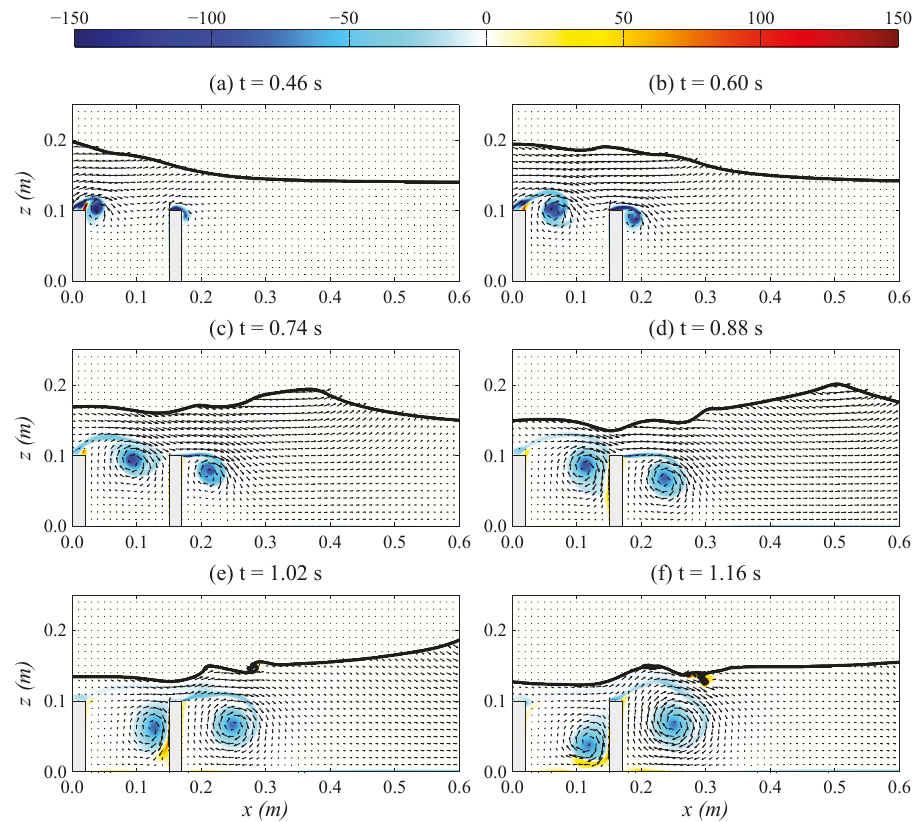
Figure 6. Simulated evolutions of the free surface elevation, velocity and vorticity (unit: s –1 ) (color map) fields for the case of D = 0.15 m at six time instants: ( a ) t = 0.46 s; ( b ) t = 0.60 s; ( c ) t = 0.74 s; ( d ) t = 0.88 s; ( e ) t = 1.02 s; ( f ) t = 1.16 s.